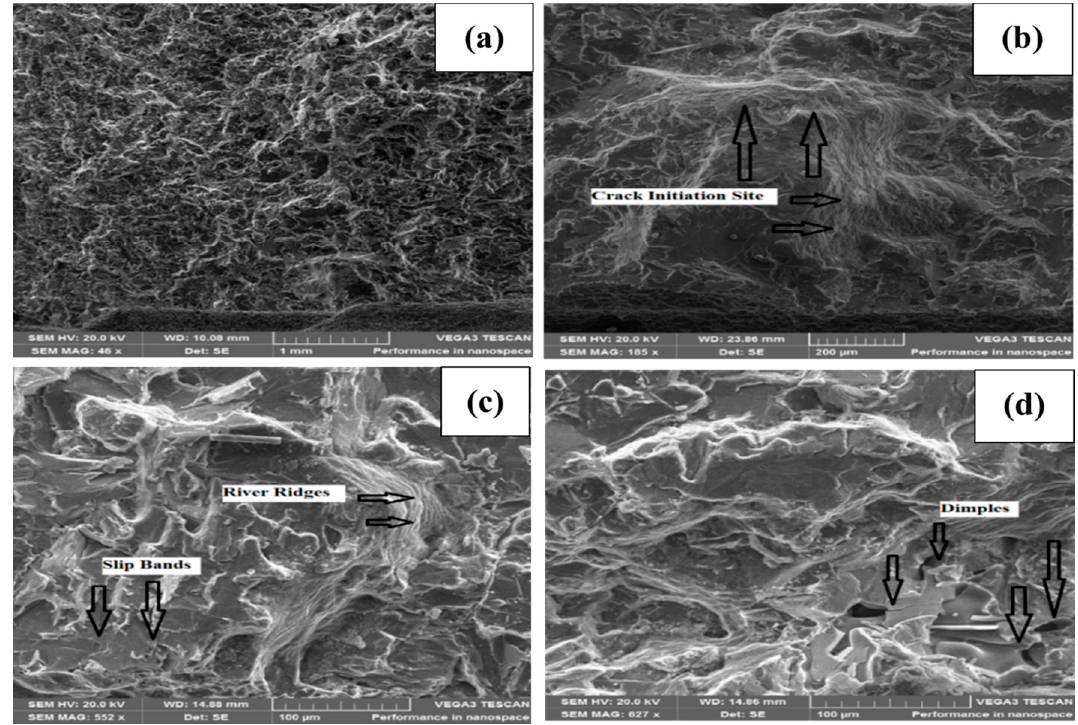
Figure 4. SEM images of fracture surface of composite: ( a ) overall image of the notch area of the specimen from where crack started, ( b ) crack initiation site of the composite from where the crack originated, ( c ) plane surfaces showing the slip bands and curved pattern depicts the river ridges of the crack pattern, and ( d ) dimples and voids shows that the crack was rupture in nature.